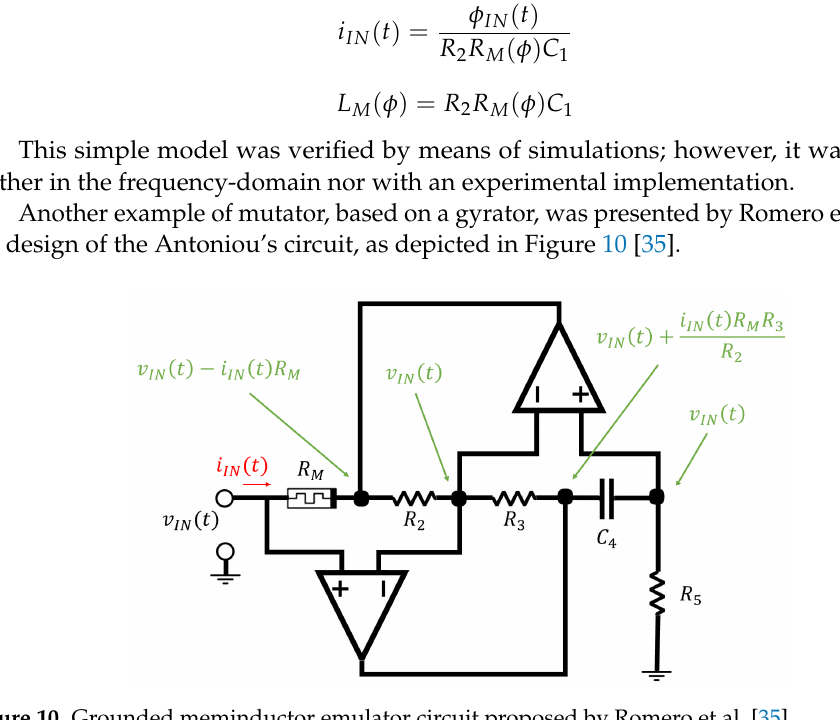
Figure 10. Grounded meminductor emulator circuit proposed by Romero et al. [35].